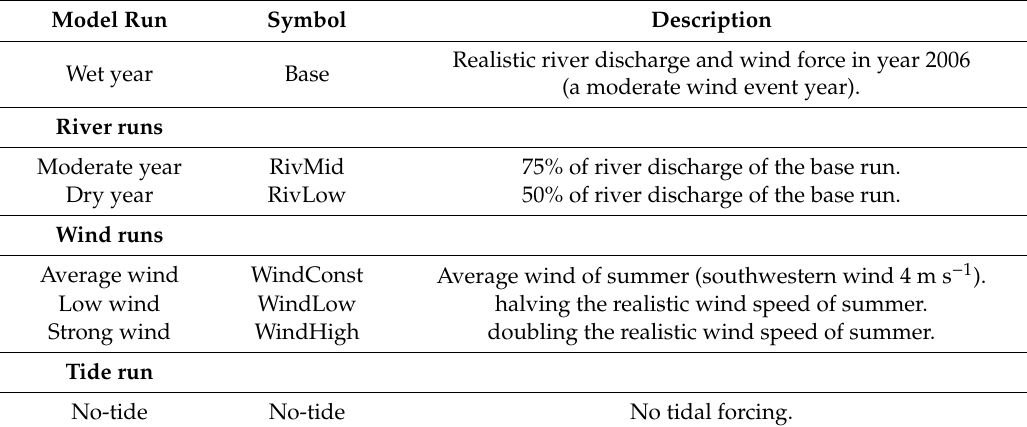
Table 1. Overview of the model